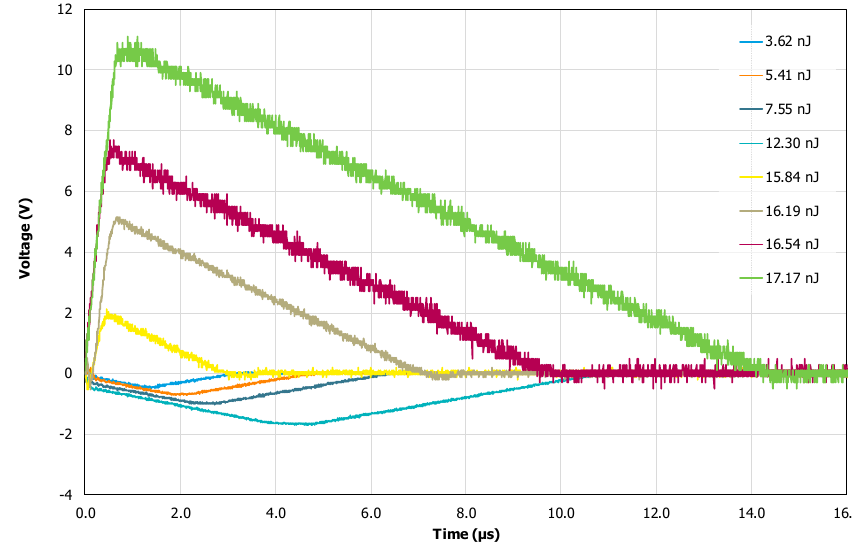
Figure 7. The response of the Q20 region to 1064 nm photons at different incident pulse energies. As can be seen from Figure 7, when the laser energy was 3.62 nJ, a negative transient voltage was observed, with an amplitude of about − 1.8 V. When the laser energy was 15.84 nJ, a positive transient voltage was observed, and the amplitude of the transient voltage increased with the increasing laser energy.